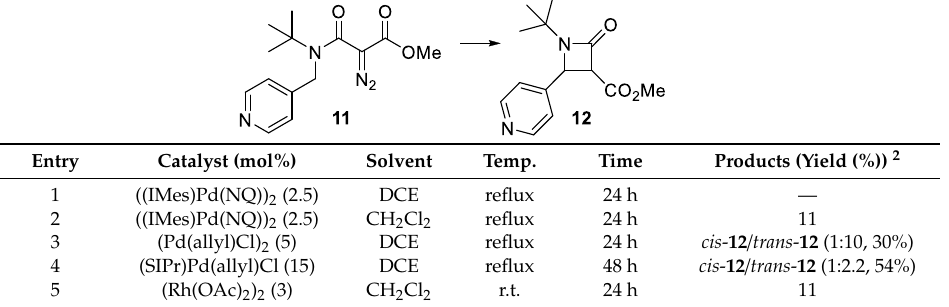
Table 4. Transition metal-catalyzed reactions of α -diazoamide 11 1 .